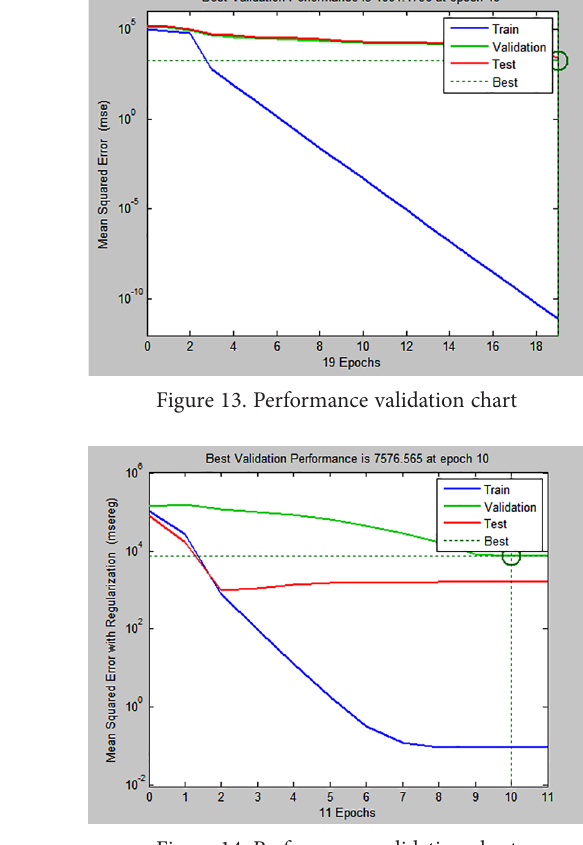
Figure 14. Performance validation chart